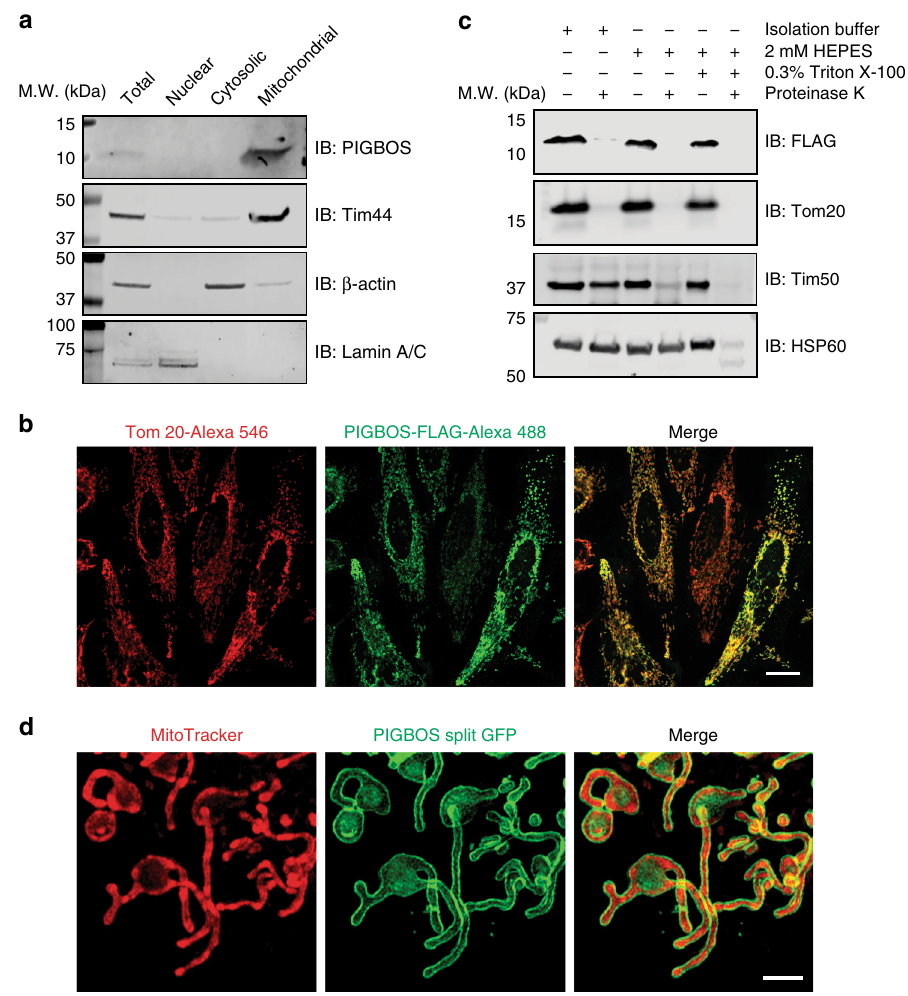
Fig. 2 PIGBOS is localized on the mitochondrial outer membrane (MOM). a Western blot analysis of nuclear, cytosolic, and mitochondrial fractions from HEK293T cells identi fi es PIGBOS as a mitochondrial microprotein. b Immuno fl uorescence imaging of HeLa cells after transfection with PIGBOS-FLAG reveals colocalization of PIGBOS (green) with the mitochondrial marker Tom20 (red), validating PIGBOS ’ s mitochondrial localization. Scale bar: 20 µ m. c Sub-mitochondrial localization using a protease protection assay reveals PIGBOS to be a mitochondrial outer membrane microprotein since proteinase K can access and degrade PIGBOS without any mitochondrial permeabilization. d Live cell imaging of COS-7 cells that were co-transfected with PIGBOS-3× GFP11 and GFP (1 – 10) results in a green fl uorescent ring around the mitochondria (MitoTracker Deep Red FM), consistent with PIGBOS localization to the MOM. Scale bar: 2.5 µ PIGBOS- Δ C-3 × GFP11 showed no detectable GFP signal, supporting that the C-terminus of PIGBOS is necessary for its interaction with CLCC1 (Fig. 4c, d and Supplementary Fig. 7).